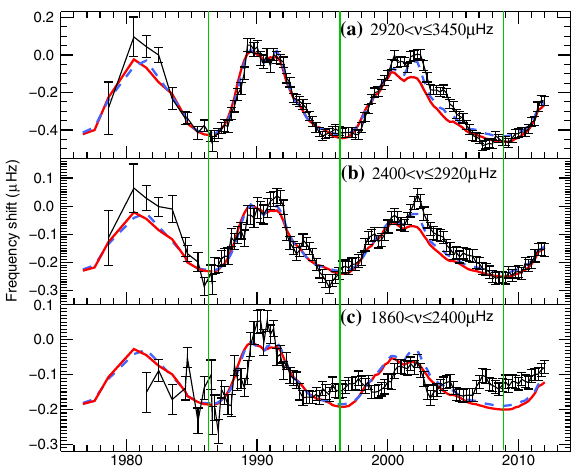
Fig. 36 Average frequency shifts of solar oscillations observed by BiSON as a function of time for three different frequency ranges. The plotted shifts were calculated with respect to the averaged frequencies during the cycle 22 maximum, specifically over the period 1988 October to 1992 April. The black points in each panel show the average shift in frequency. The blue dashes show the 10.7-cm flux and the red dot- dashed line is the International Sunspot Number. The green vertical lines mark the approximate positions of solar minima. (Image courtesy of Anne-Marie